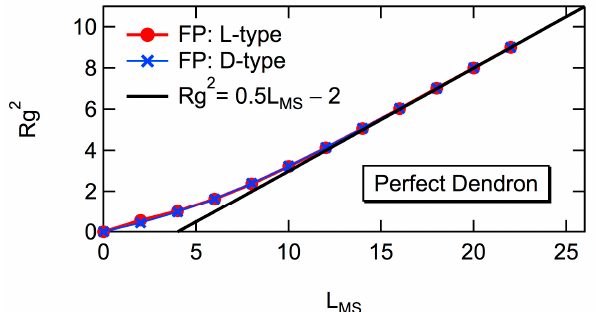
Figure 20. Relationship between Rg 2 and L MS for perfect dendrons, when the focal point is the L-type (red circle) and the D-type (blue cross). For both cases, the relationship is represented by Equation (14) for large polymers.